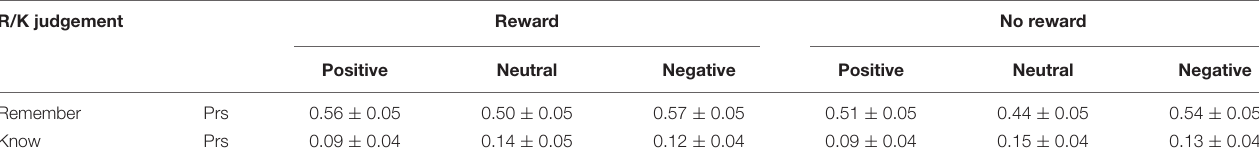
TABLE 3 | Mean Prs of remember and know responses in each condition. R/K